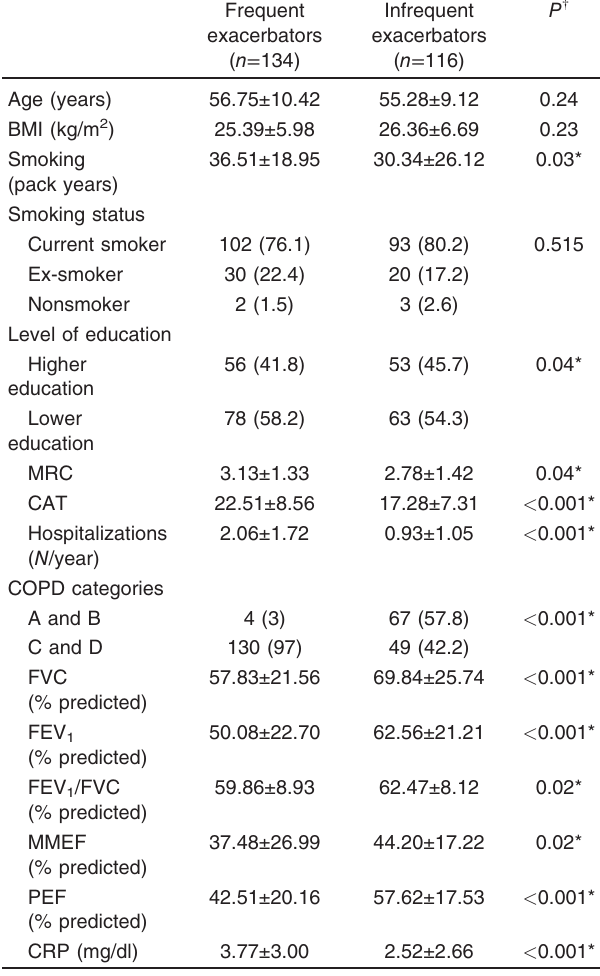
Table 1 Data description and comparisons between both groups concerning anthropometric, clinical, spirometry, and laboratory